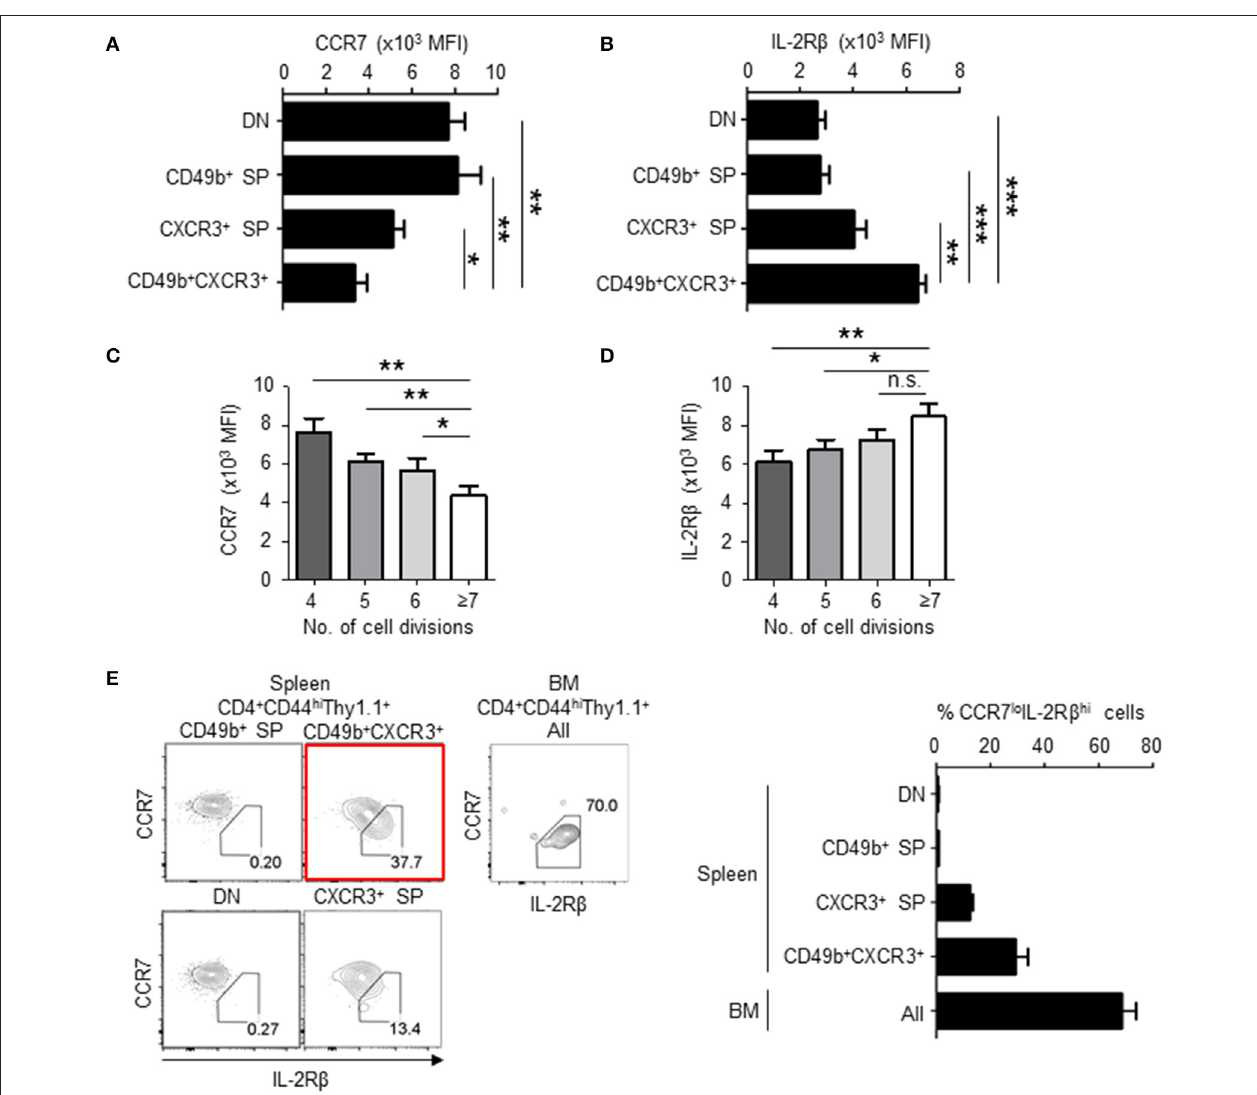
FIGURE 4 | BM memory precursors downregulate CCR7 and upregulate IL-2R β following cell division. As described in Figure 1 , C57BL/6 mice were transferred, immunized and analyzed by flow cytometry on day 5 after immunization. (A,B) CD49b + CXCR3 + memory precursors express low level of CCR7 and high level of IL-2R β . The geometric mean of fluorescent intensity (MFI) of CCR7 (A) and IL-2R β (B) expression in splenic subpopulations defined by expression of CD49b and CXCR3 is shown n = 8. (C,D) Cells with enhanced numbers of divisions downregulate CCR7 and upregulate IL-2R β in the CD49b + CXCR3 + subpopulation. The GMFI of CCR7 (C) and IL-2R β (D) within the CD49b + CXCR3 + subpopulation is shown for each cell division ( n = 7). (E) IL-2R β hi CCR7 lo cells are enriched in the CD49b + CXCR3 + subpopulation. Gating plots (left) show the expression of CCR7 and IL-2R β in splenic subpopulations defined by expression of CD49b and CXCR3 and all subpopulations of the BM. A bar chart displays the percentages of IL-2R β hi CCR7 lo cells in each subpopulation of the spleen and all subpopulations of the BM n = 8. These data are representative of two independent experiments. Data are shown as mean ± SD. * p < 0.05, ** p < 0.01, *** p < 0.001, n.s.: not